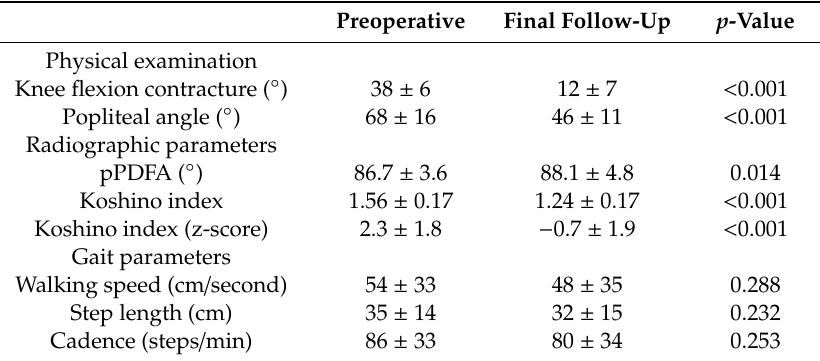
Table 2. Outcome Measures.